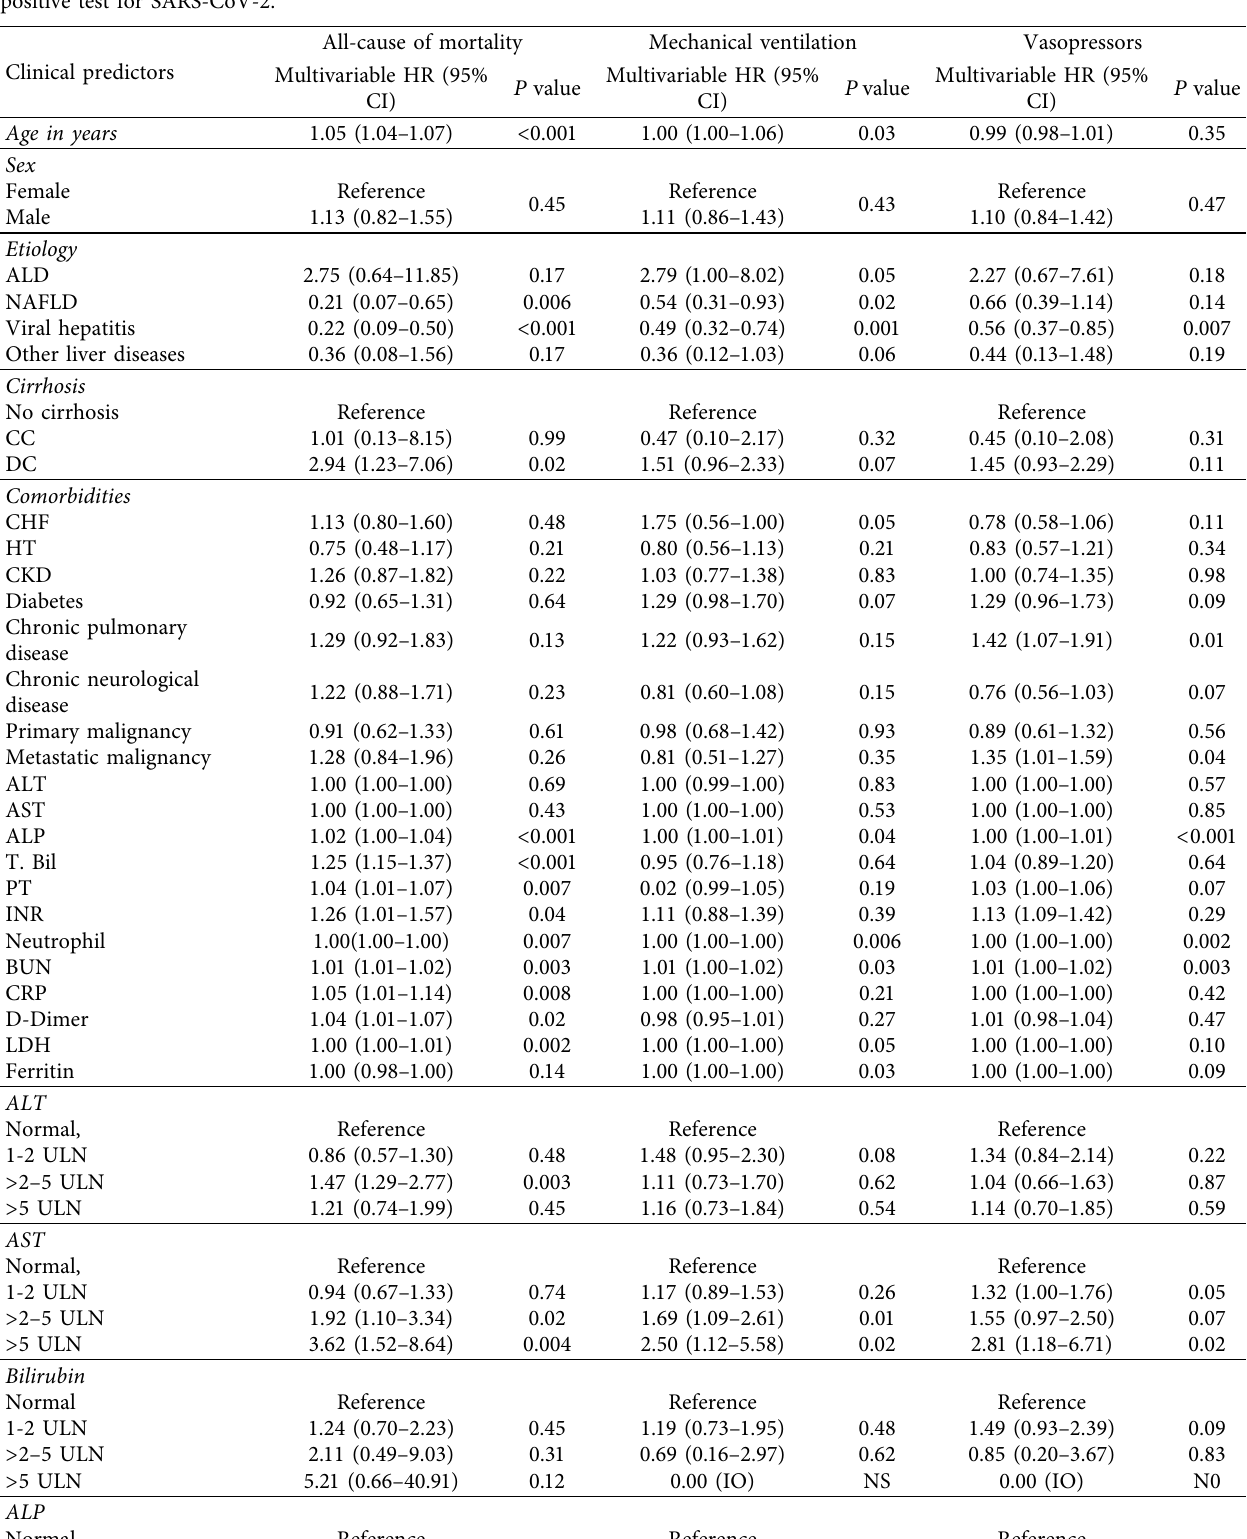
Table 2: Multivariable ∗ Cox proportional hazards model for major outcomes among hospitalized patients with chronic liver disease and a positive test for